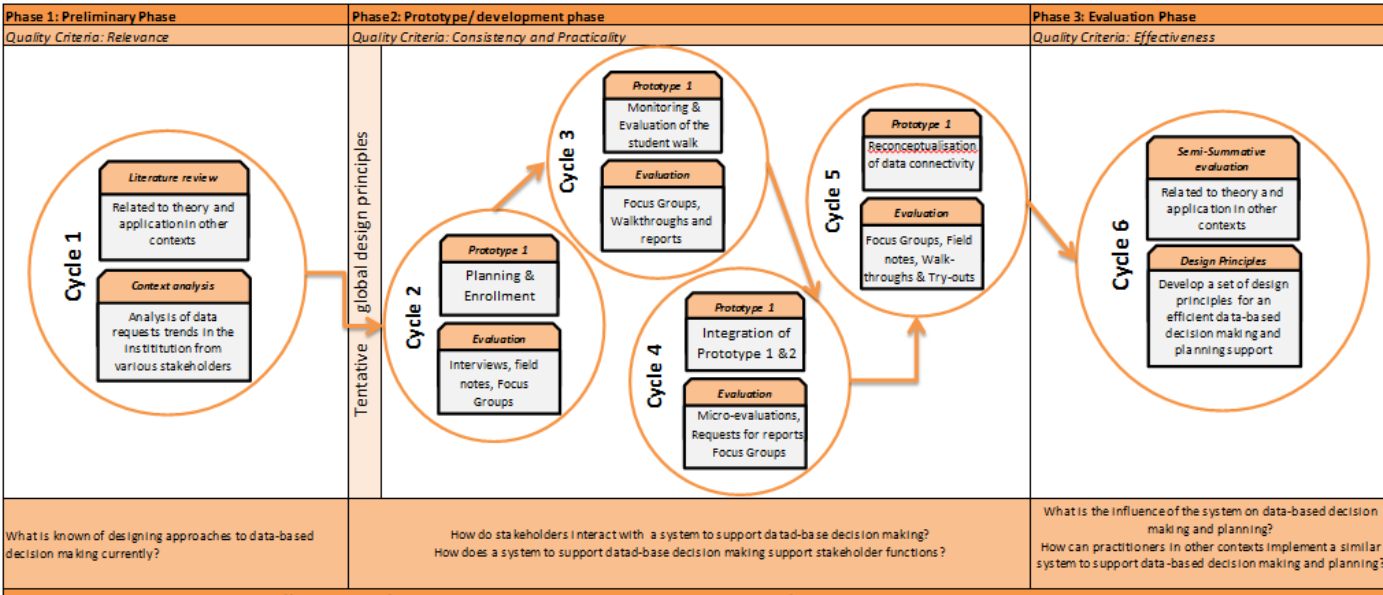
Figure 2. Design Research Process for Digital DNA , including research questions and Evaluative